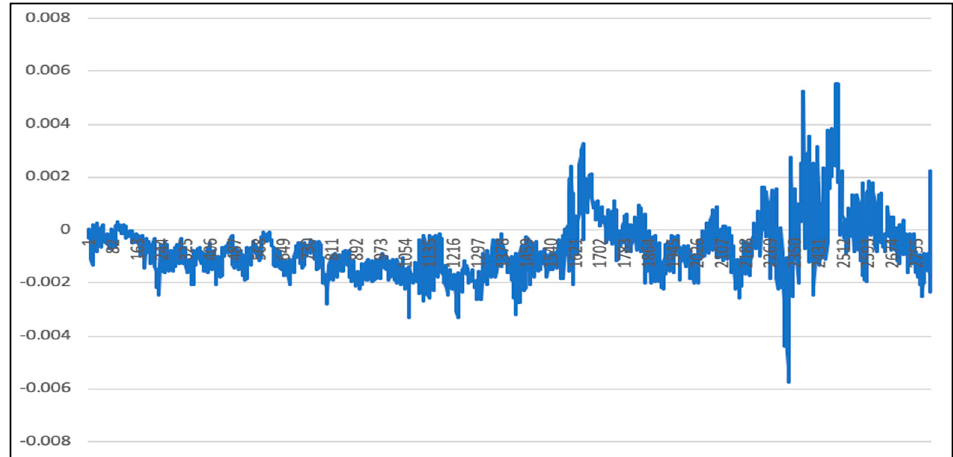
Figure 22. Error map of LSTM-SVR I prediction results and actual results (8500th data to 11,300th data).